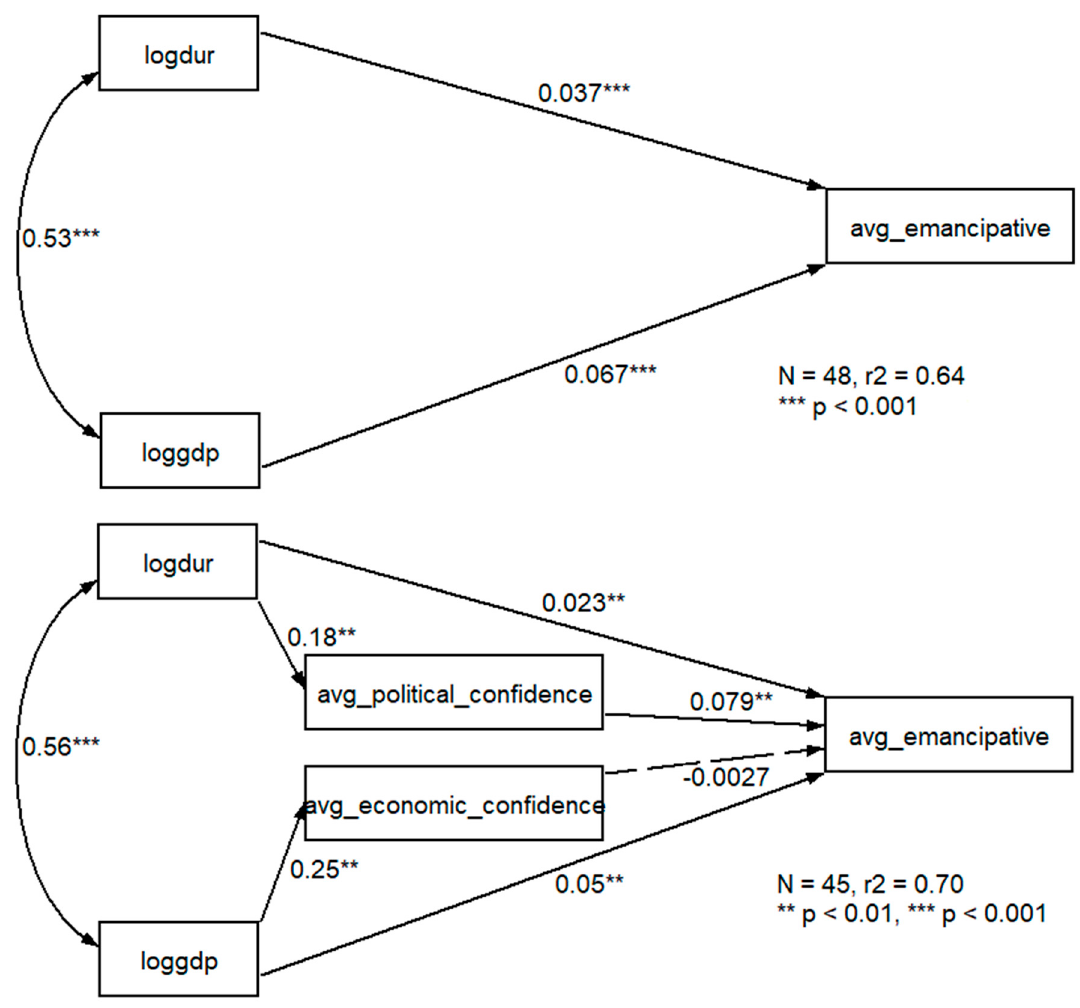
Figure A1. SEMs for emancipative values (using logdur as a proxy for political stability). Note: Solid lines are used to denote significant paths.